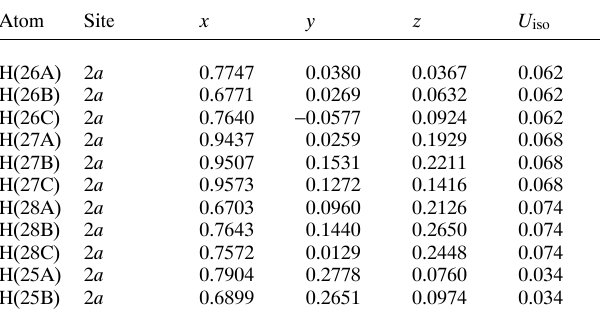
Table 2. A tomic coordin a tes a nd displ a cement p a r a meters (in Å 2 )